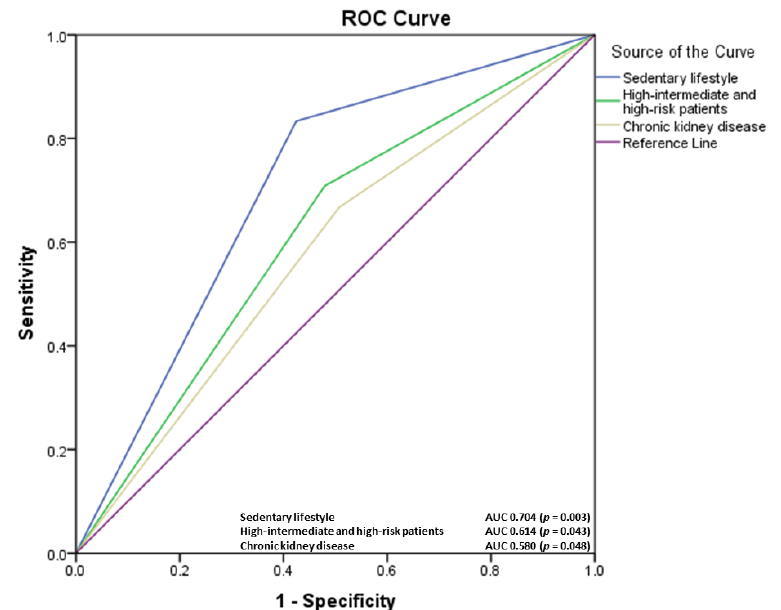
Figure 3. The receiver operating characteristic curve of factors associated with specialist reassessment before the 6-month assessment